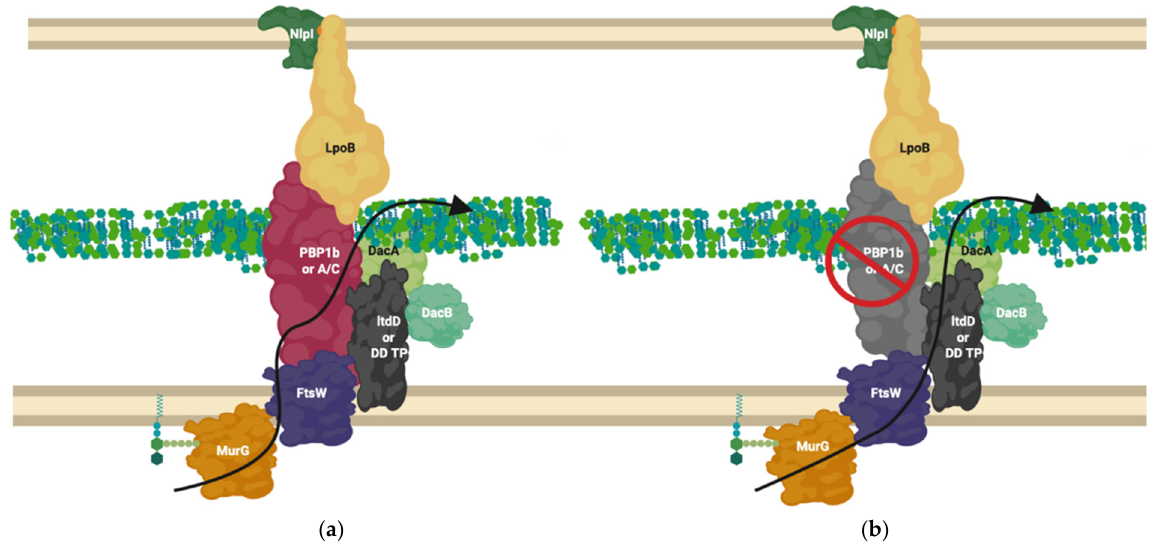
Figure 8. LdtD in complex with PBP1b and DacA. ( a ) PBP1b active complex performs 3-4 crosslinking; ( b ) On β -lactam challenge PBP1b activity is reduced, allowing LtdD, in complex with DacA and DacB, to take over crosslinking and allow cell viability [59,69]. The complex represented above is one of many possible complexes. The flippase is represented by FtsW due to its potential bifunctional role for simplification but likely involves MurJ, this is one of many possible configurations. MurG ligase has been shown to interact with FtsW [60,66].